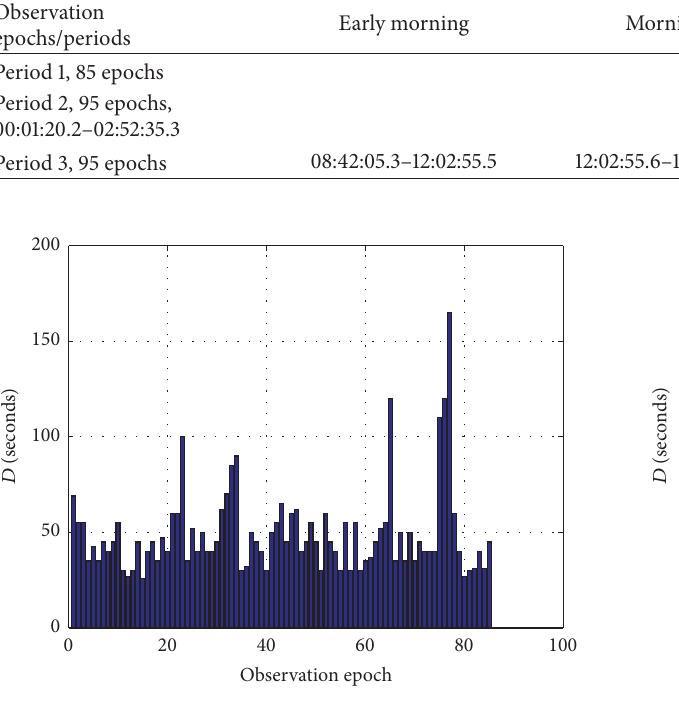
Figure 7: Back-to-back duration using period 1 observation data.